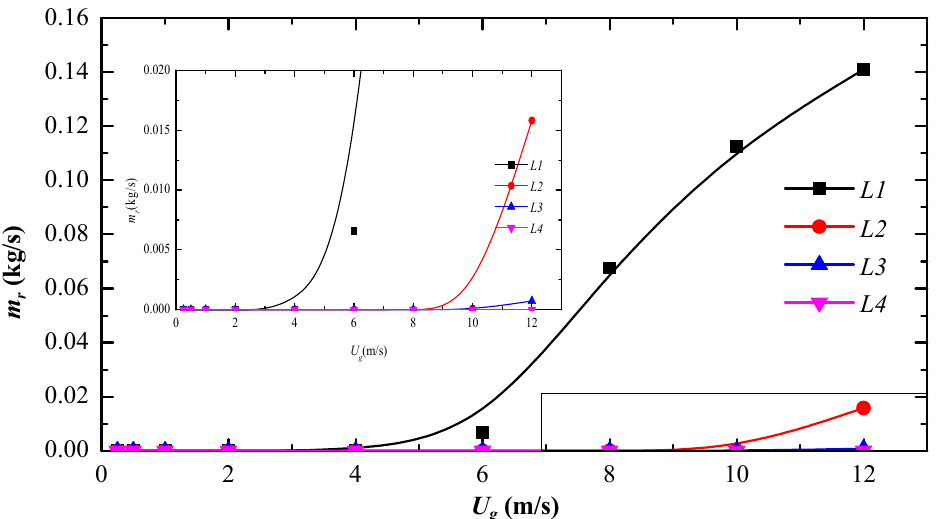
Figure 17. Numerical results of droplet mass flow rate versus Reynolds number with different wavelength.